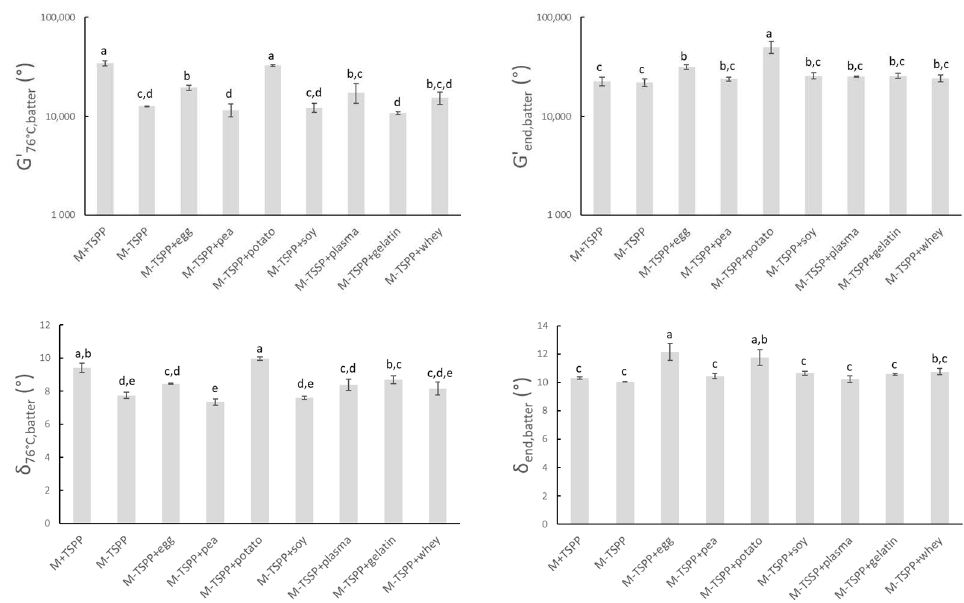
Figure 3. G’ 76 ◦ C,batter and δ 76 ◦ C,batter represent the elasticity modulus and phase angle, respectively, of sausage batters during rheological measurements at the end of isothermal heating at 76 ◦ C. G’ end,batter and δ end,batter represent the elasticity modulus and phase angle of sausage batters after further cooling from 76 to 20 ◦ C. Mean values and standard deviations are presented (n = 2). Abbreviations used: M (model) and TSPP (tetrasodium pyrophosphate). Letters a–e: different letters indicate significant differences ( p < 0.05) between treatments.